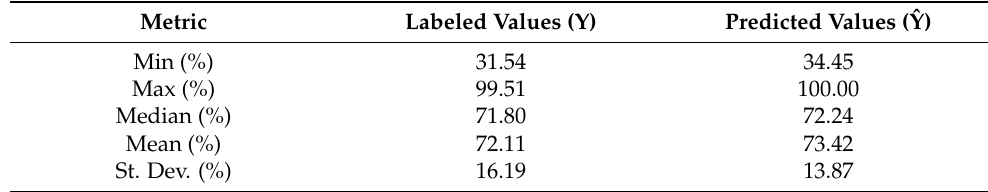
Figure 6. Plot of predicted vs. labeled recoveries from MLP regression on the unseen test set. Samples are sorted based on the target labels to highlight residual distances; predictive power appears best in the mid ‐ to ‐ upper recovery ranges (~65–95%). Table 1. Comparison of summary statistics for labeled and predicted gold recoveries from MLP regression (500 epochs) on the test set ( n = 450